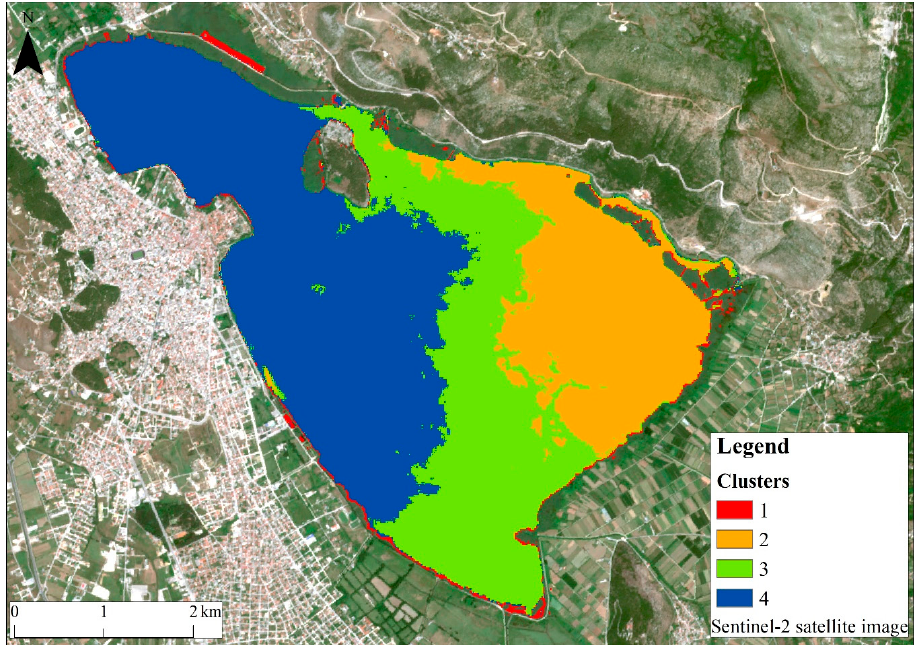
Figure 9. The frequency of the optimal number of clusters retrieved by 24 models.